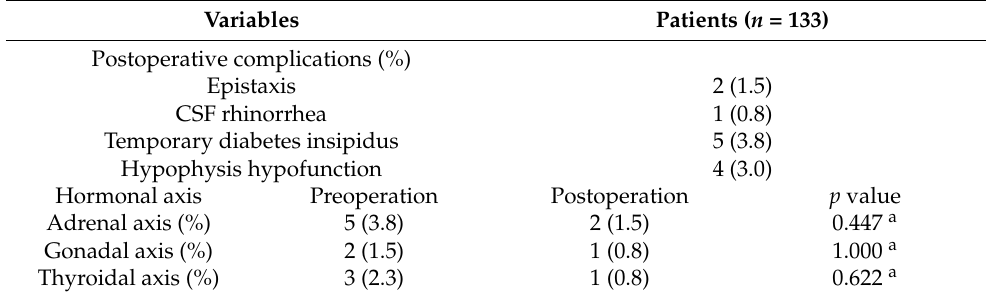
Table 6. Postoperative complications and evaluation of hormonal involvement preoperation and post